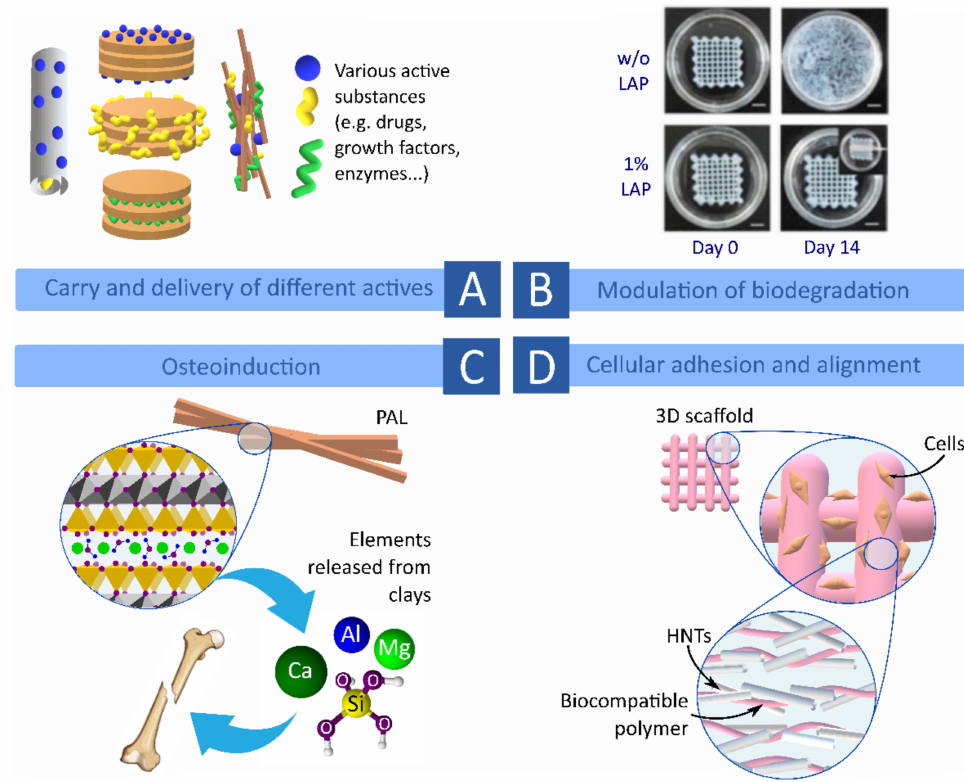
Figure 19. Schematic representation of some of the functional roles of clay minerals in 3DP and 3DBP constructs. ( A ) Clay minerals as carriers of different active substances. ( B ) Effect of LAP in biodegradation of ALG and TEMPO BC. Photos were reproduced with permission from [104], Elsevier, 2020. ( C ) Osteoinductive effect of clays. ( D ) Clays were also proven to improve cellular adhesion and